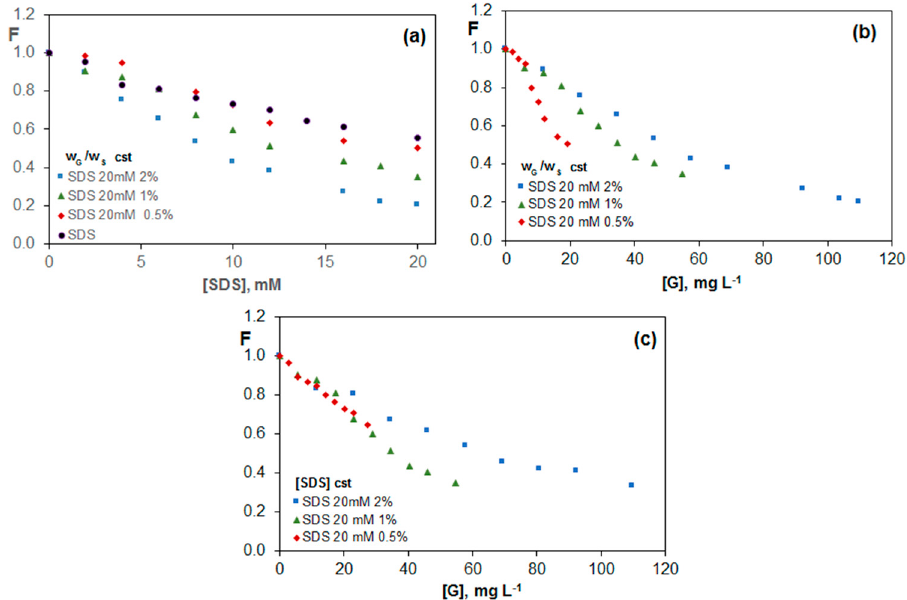
Figure 6. Evolution fluorescence of vitamin B 2 (F) for G/SDS dispersions as a function of SDS ( a ) and graphene ( b , c ) concentration for solutions with a constant G/surfactant weight ratio ( a , b ) or constant SDS concentration ( c ).